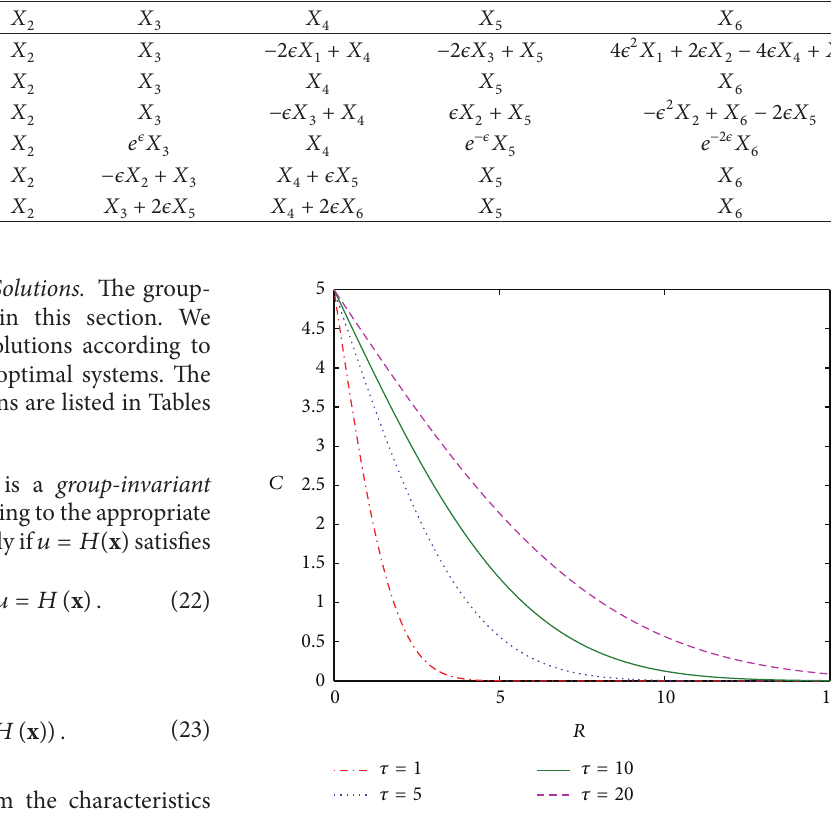
Figure 1: Contaminant concentration profile along the radius. Here = 5 𝐶 0